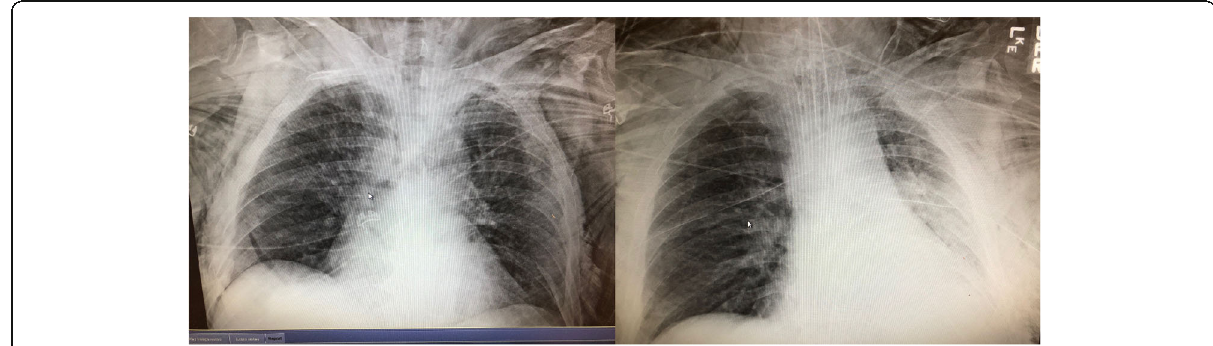
Fig. 3 Progression of preoperative chest X-ray findings, showing an evolving large pulmonary contusion with an atelectatic component on the left pulmonary